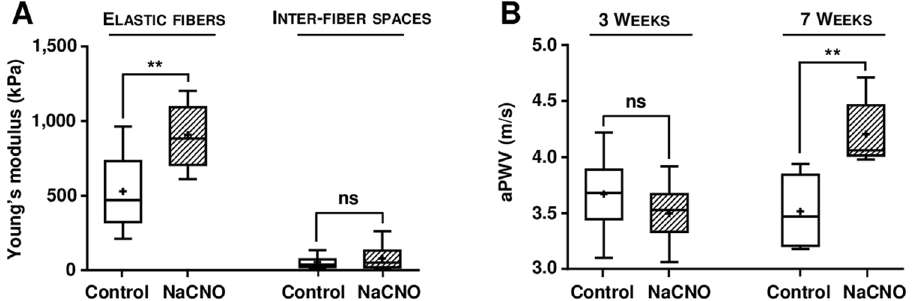
Figure 6. Effect of diet-induced carbamylation on aortic elastic fiber stiffness and aortic pulse wave velocity in ApoE −/− mice. ( A ) Young’s modulus (YM) was measured by atomic force microscopy pictures using a Peak Force QNM mode in 10 μm cross-sections of aortas from ApoE −/− mice fed for 3 weeks with water supplemented with 1 mM NaCl (control) or 1 mM NaCNO. Quantification of the YM [expressed in kilopascals (kPa)] was carried out directly on elastic fibers and on the interfiber spaces. ( B ) Aortic pulse wave was measured at the thoracic and abdominal levels by two Doppler probes in ApoE −/− mice. Results of aortic pulse wave velocity (aPWV) were expressed in meters per second (m/s). For ( A ) and ( B ), results were presented as boxplots, in which the error bars represent minimum and maximum values, the horizontal bars and the crosses indicate median and mean values, respectively, and the extremities of the boxes indicate interquartile ranges. Values were compared using the non-parametric Mann–Whitney’s U test ( ns not significant, ** p <